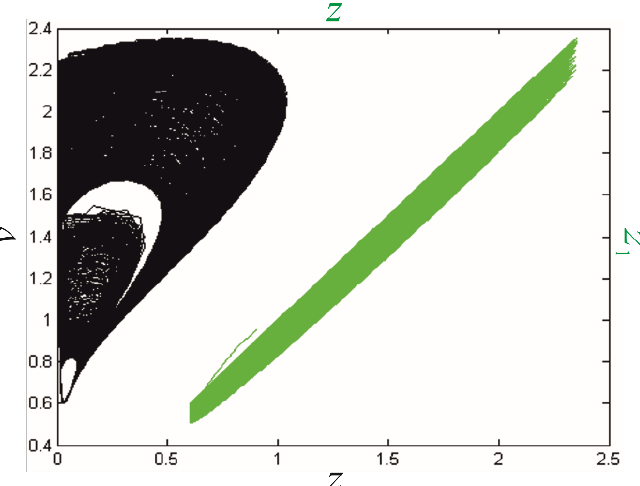
Figure 15. Master ( z , v )—black color, and master–slave ( z , z 1 )—green color phase portraits.